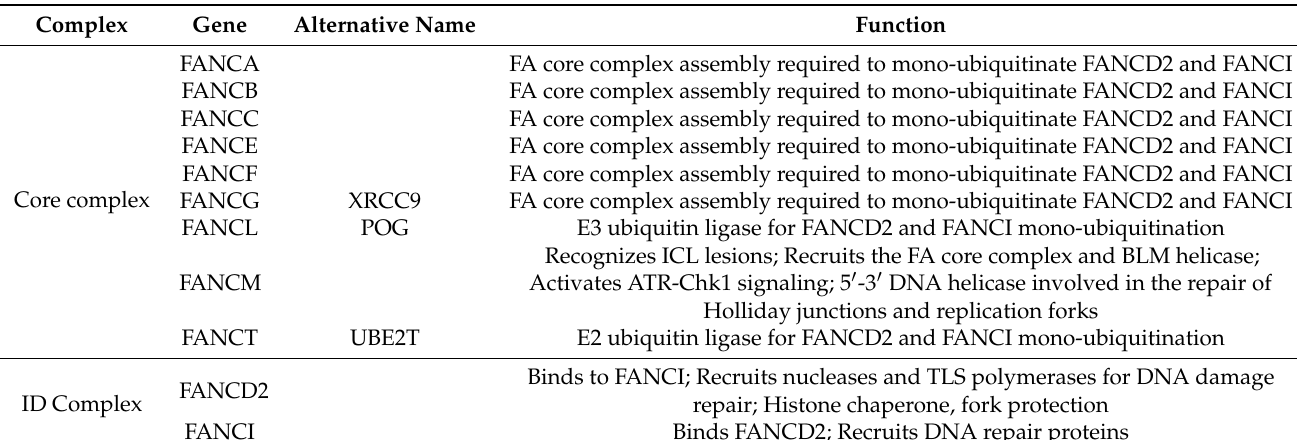
Table 1. Fanconi anemia pathway genes and known associated